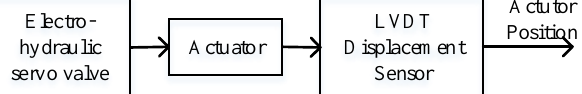
Figure 10. Fuel metering diagram.